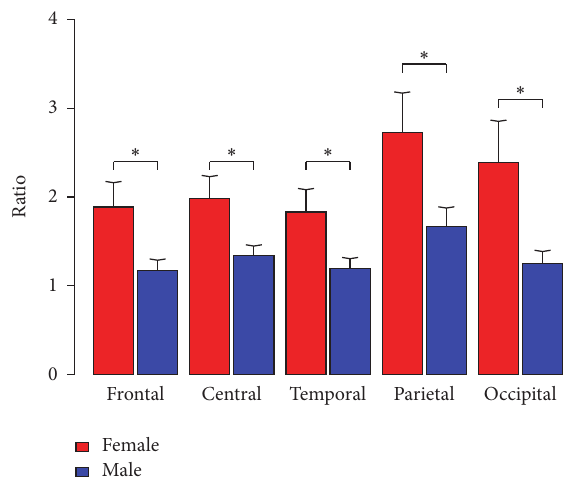
Figure 1: Difference alpha/theta ratio between gender in the different brain areas. ∗ 𝑝 < .050 .